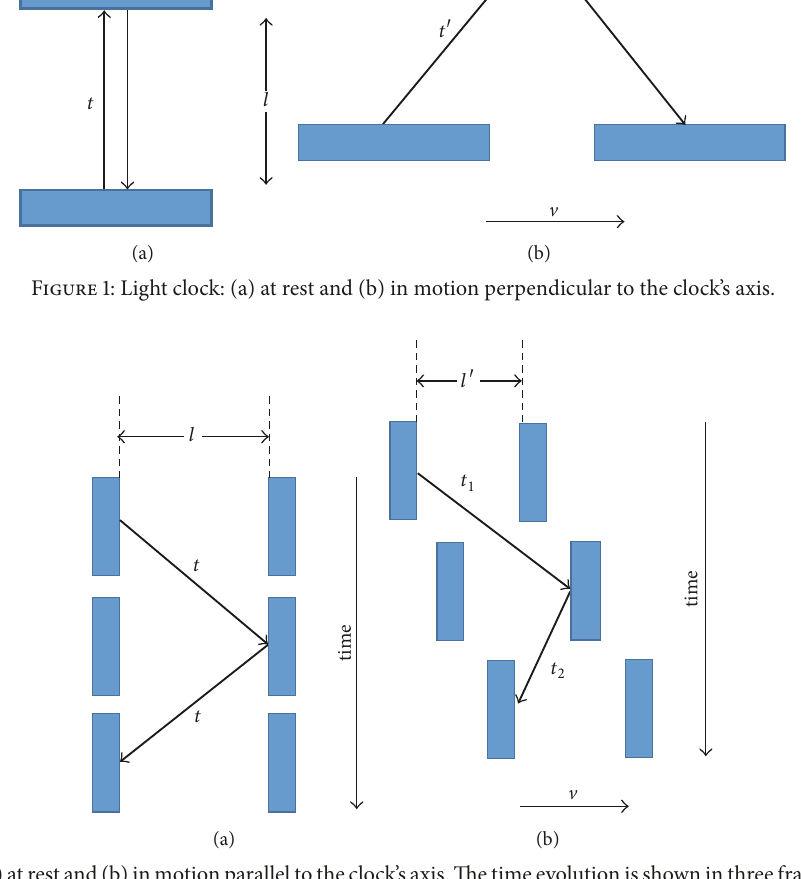
Figure 2: Light clock: (a) at rest and (b) in motion parallel to the clock’s axis. The time evolution is shown in three frames stacked up